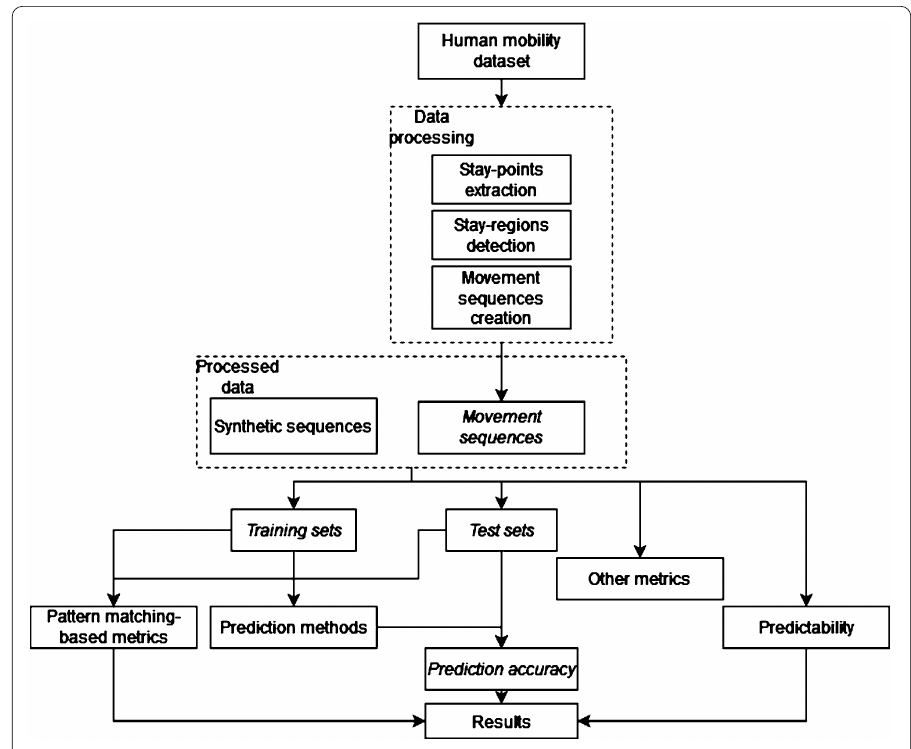
Figure 1 Workflow adopted in this study. Each block’s name (apart from those written in italic font) corresponds to the particular subsection of the workflow description. First, data were processed into movement sequences, after which predictability, stationarity, regularity and proposed metrics were calculated. Results were compared against the accuracy of mobility